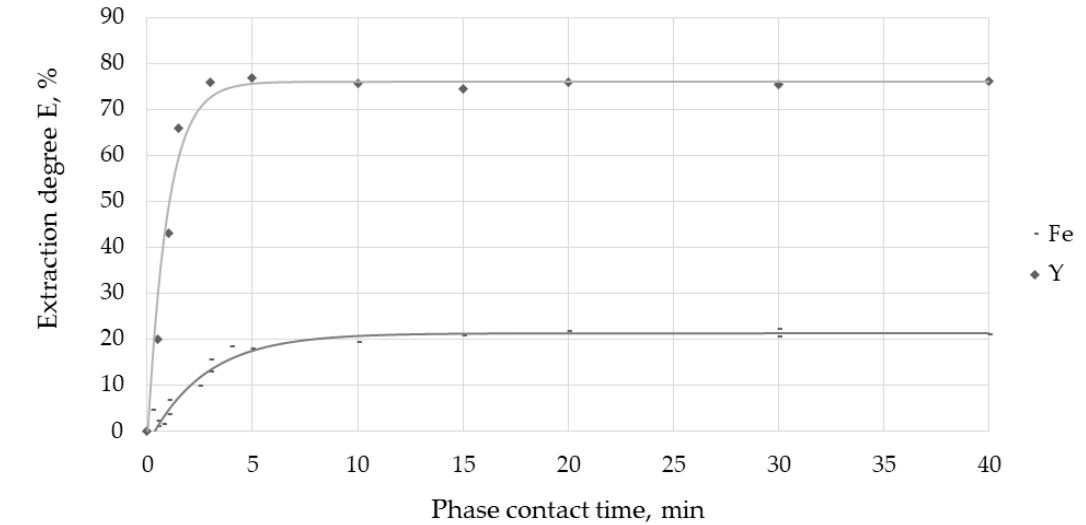
Figure 10. The dependences of the yttrium and iron (3 + ) cations extraction degree on the phase contact time.